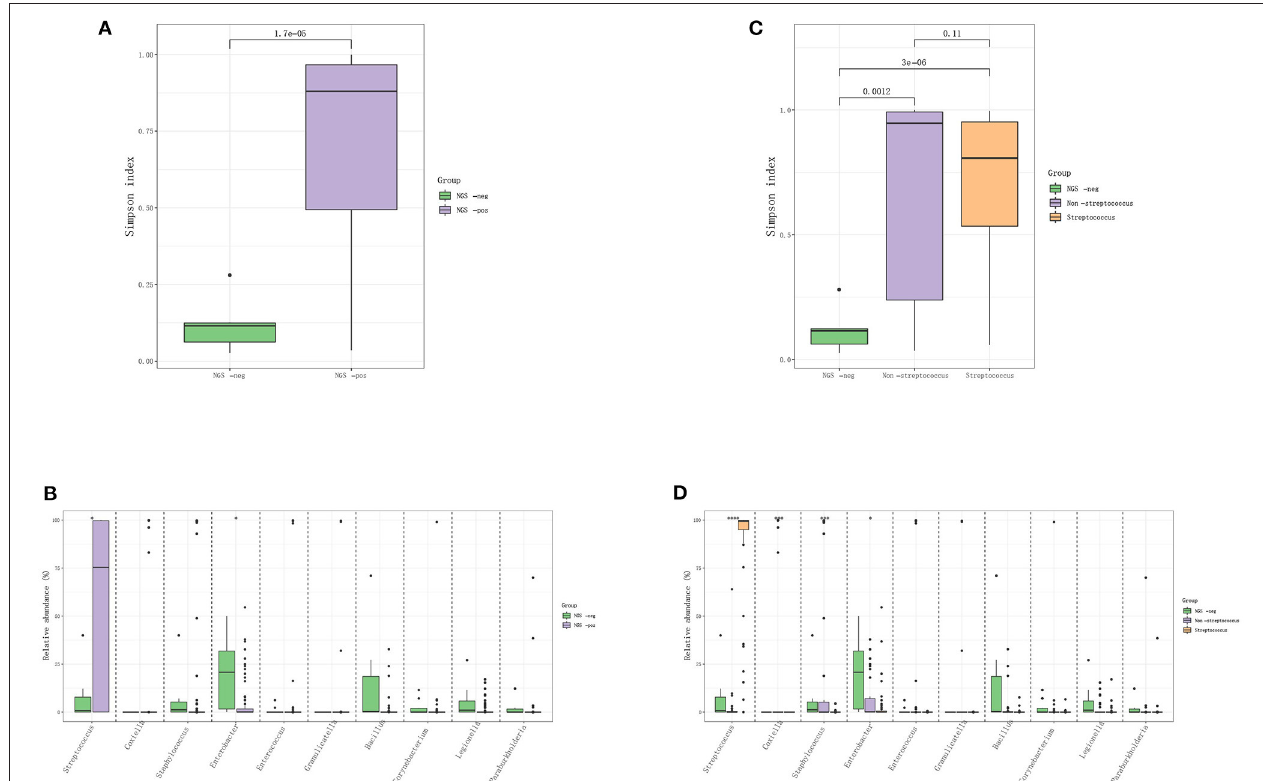
FIGURE 2 | The difference in the distribution of pathogens between mNGS negative and mNGS positive IE patients. (A,B) Comparison of Simpson index and species-level difference between mNGS negative group and mNGS positive group; (C,D) comparison of ACE index and species level difference among mNGS negative group, mNGS positive non-streptococcal infection group, and mNGS positive streptococcal infection